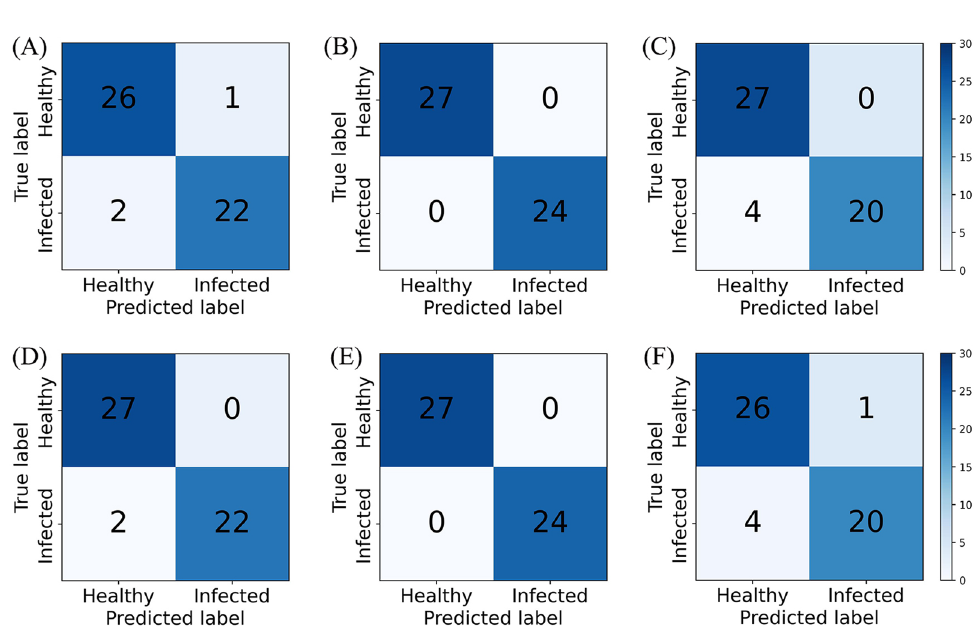
Figure 6. Confusion matrices of the PLS-DA and SVM models based on band screening under SNV preprocessing. ( A ) SNV-PLS-DA. ( B ) SNV-CARS-PLS-DA. ( C ) SNV-SPA- PLS-DA. ( D ) SNV-SVM. ( E ) SNV- CARS-SVM. ( F ) SNV-SPA-SVM.